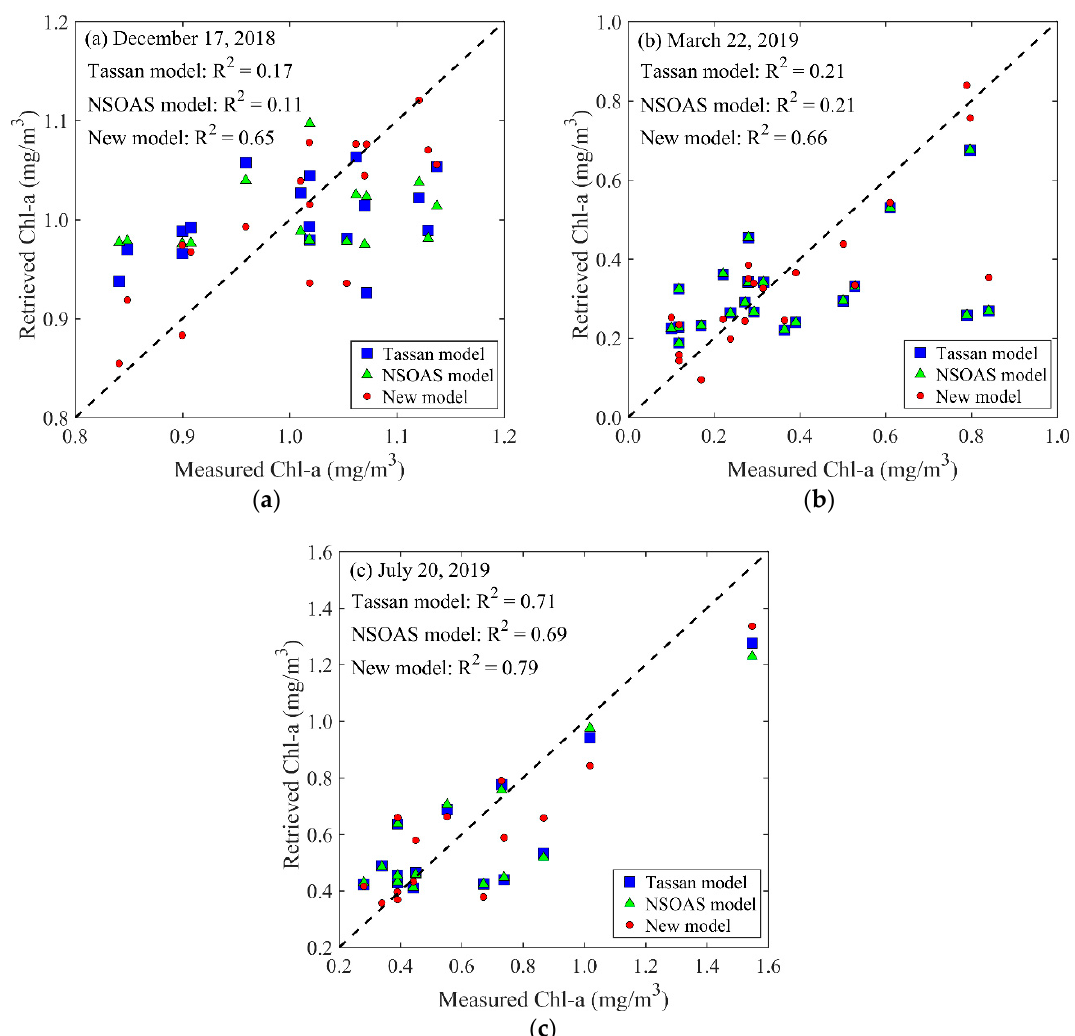
Figure 9. Comparison of in situ measured Chl-a concentrations and retrieved Chl-a concentrations by Tassan, National Satellite Ocean Application Service (NSOAS), and the new models: ( a ) comparison for 17 December 2018; ( b ) comparison for 22 March 2019; and ( c ) comparison for 20 July 2019. Table 3. Accuracy comparison for Chl-a concentration retrieval using Tassan, NSOAS, and new models on 17 December 2018, 22 March 2019, and 20 July 2019.